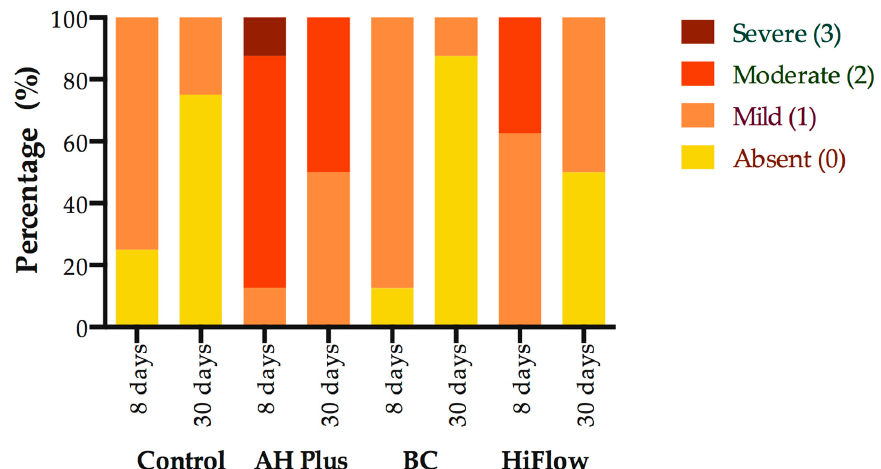
Figure 5. Comparison of inflammatory reaction scores at 8 and 30 days for the control group and root canal sealers. Mann–Whitney U test for within group comparison, p ≤ 0.05. Data are presented as percentage of total. ( n = 8 for 8 days; n = 8 for 30 days).